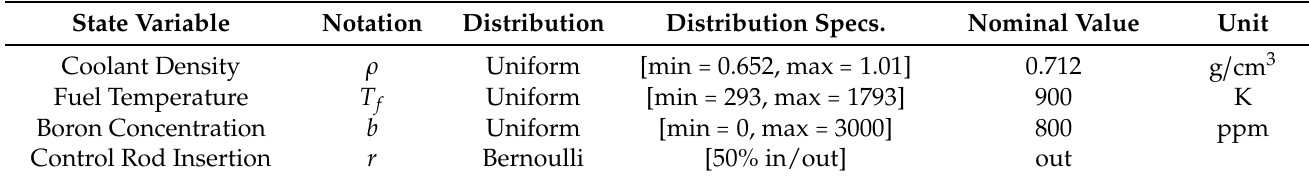
Table 1. State variable distributions independently sampled in each burnup